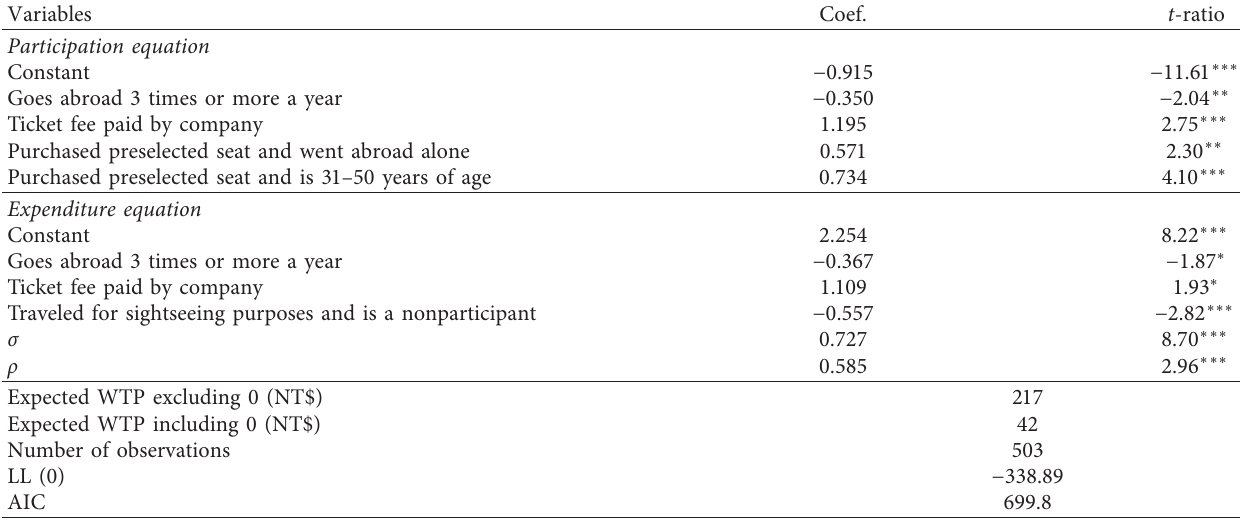
Table 9: Estimated result of the model for seat preselection (forward zone seat).